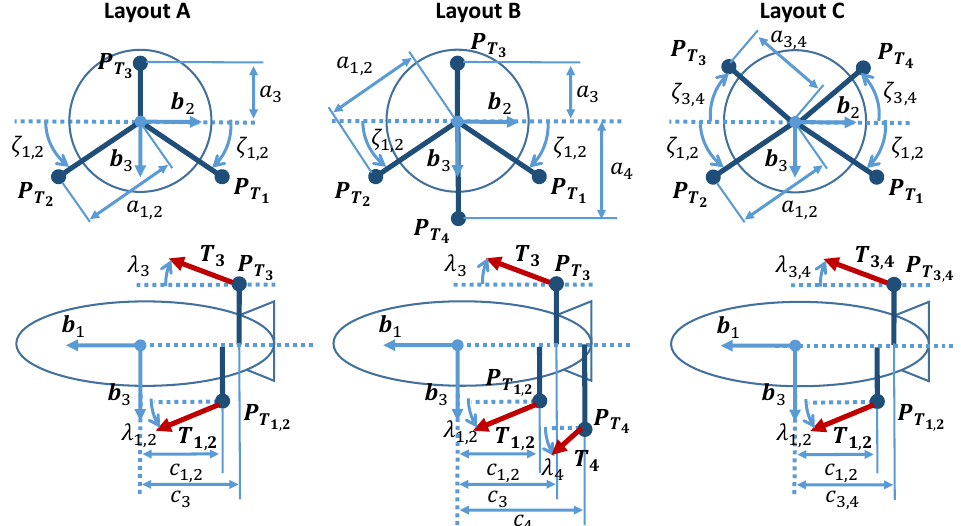
Figure 3. Three-thruster layout configurations and geometrical